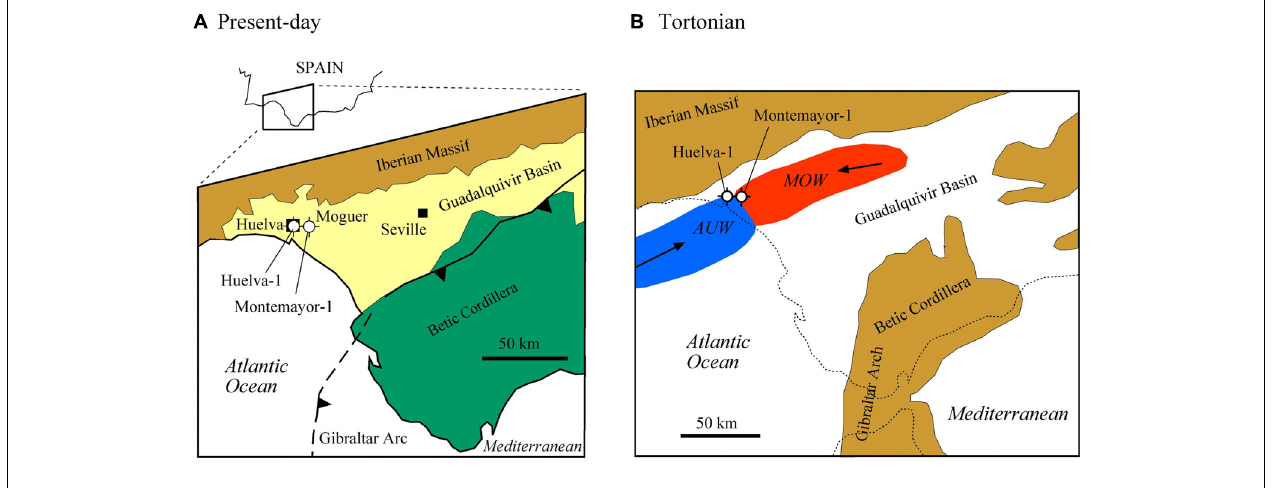
FIGURE 2 | (A) Geological sketch map of the lower Guadalquivir Basin, with location of the two studied boreholes (Huelva-1 and Montemayor-1). (B) Paleogeographic reconstruction of the Guadalquivir Basin in the late